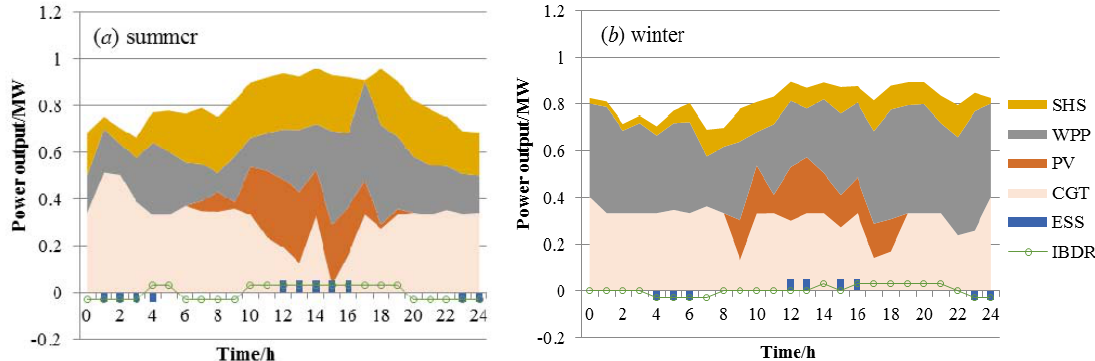
Figure 6. Output distribution of VPP power generation on typical day: ( a ) summer and ( b ) winter.